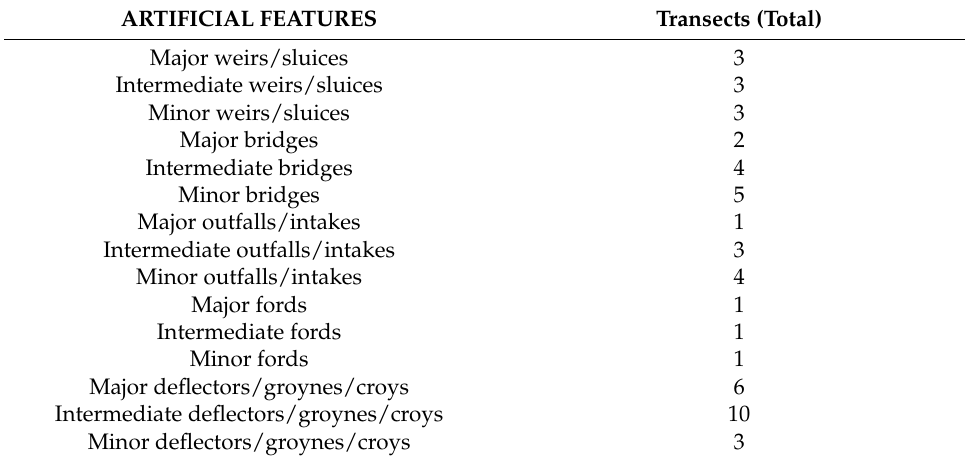
Table 1. Representativeness of observations in Section